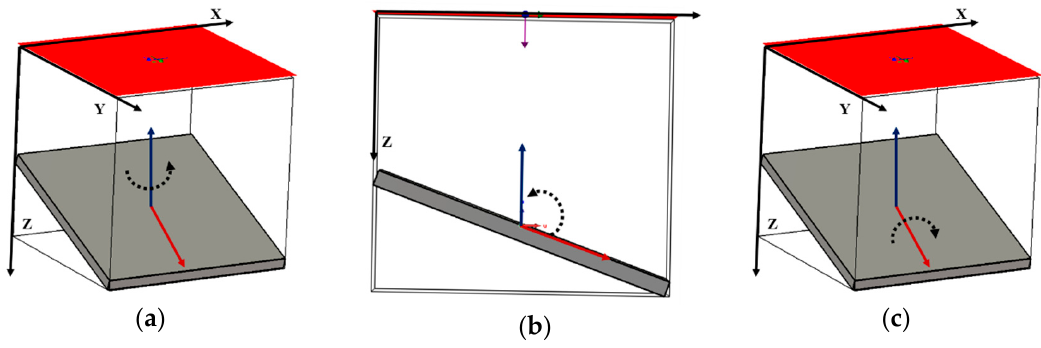
Figure 4. Simplified sketch of the employed nomenclature: ( a ) Strike angle; ( b ) dip angle; and ( c ) azimuth angle.